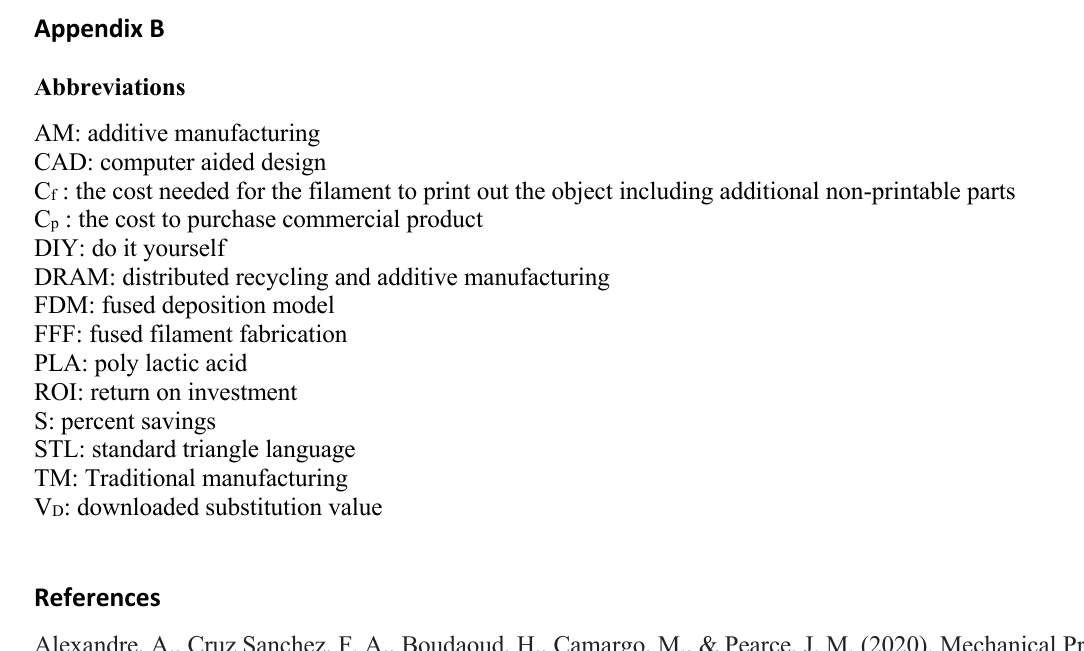
Figure A3: Derivatives of Cederberg’s face shield design on YouMagine part